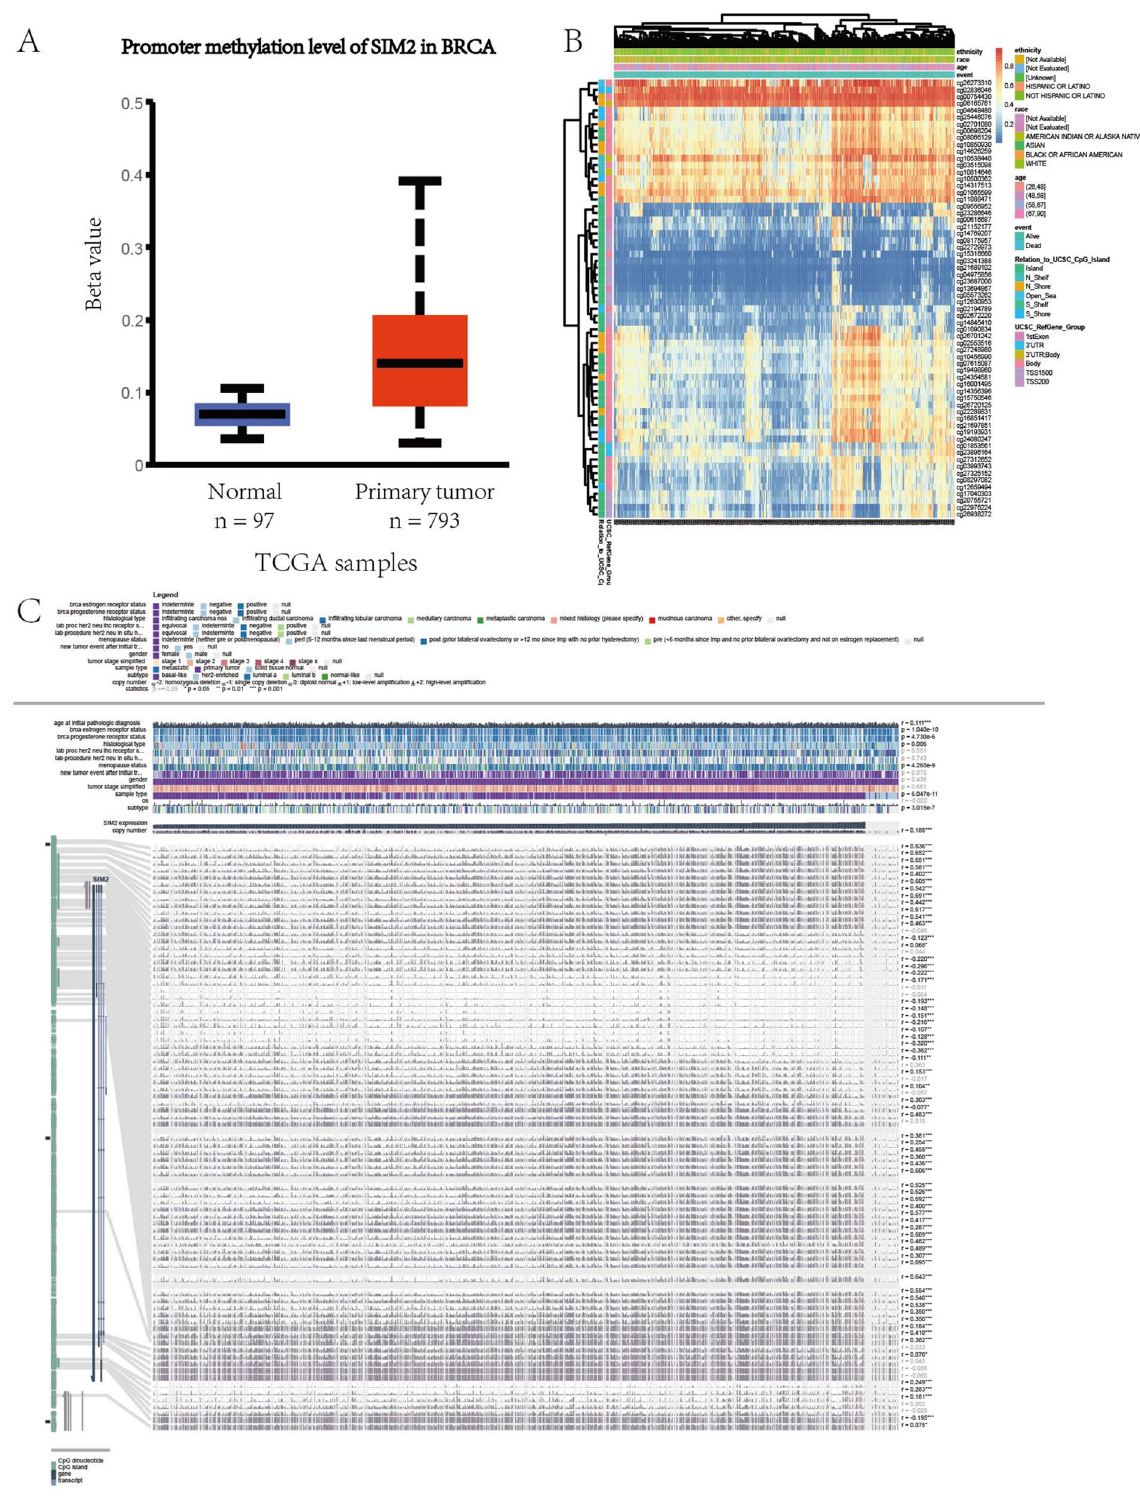
Figure 16. Analysis of SIM2 and methylation. ( A ) The promoter methylation level of SIM2 in BRCA. ( B ) The correlations between methylation sites of SIM2 and clinical features in BRCA. ( C ) The methylation information of CpG islands of